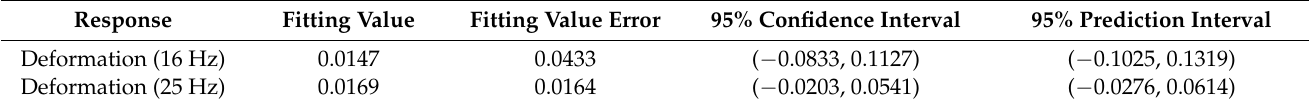
Table 7. Response optimizer optimization results of member damping design .